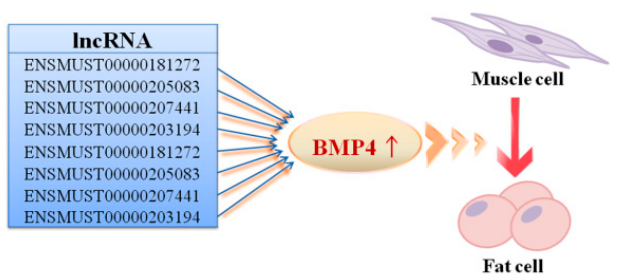
Figure 6. The target predication and GO analysis indicate that eight lncRNAs are related to cell fate decision in myoblasts based on the target gene, BMP4.